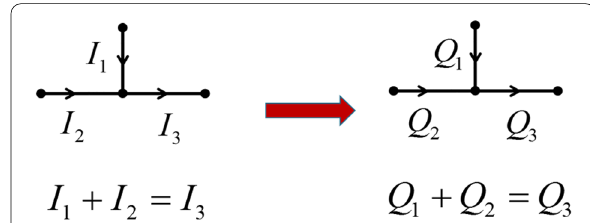
Figure 6 Derivation of heat relationship